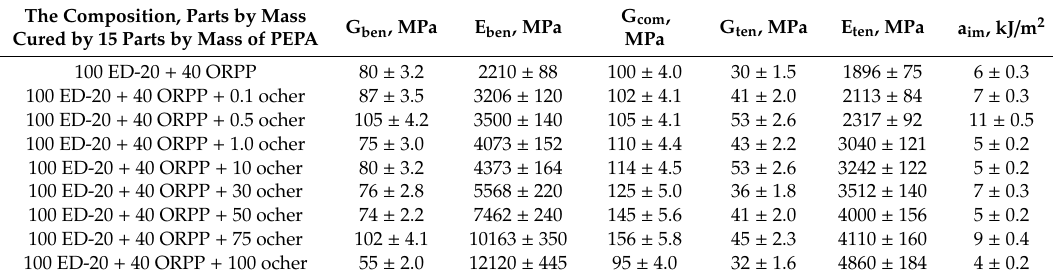
Table 2. Properties of epoxy